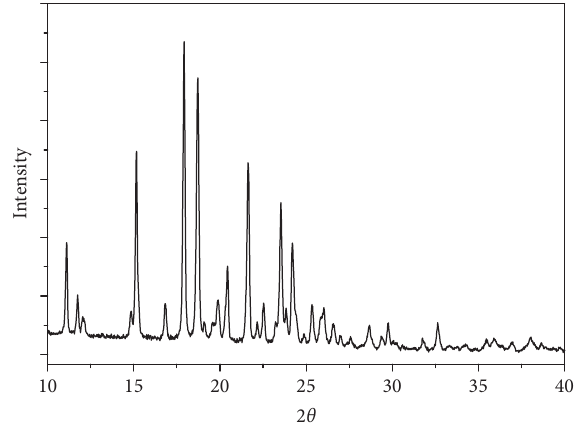
Figure 11: XRD of manganese(II) complex.